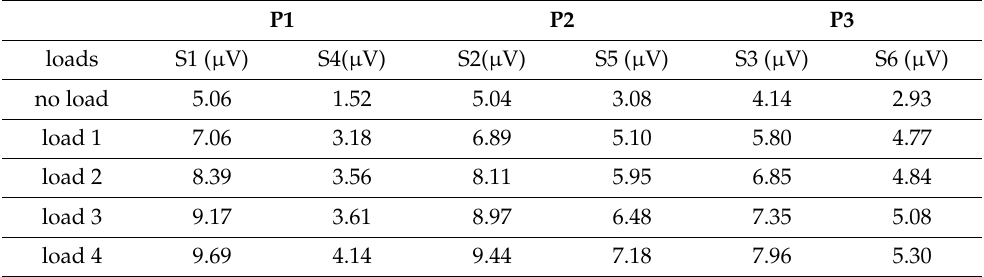
Table 1. Example of measurements obtained from three positions for the healthy